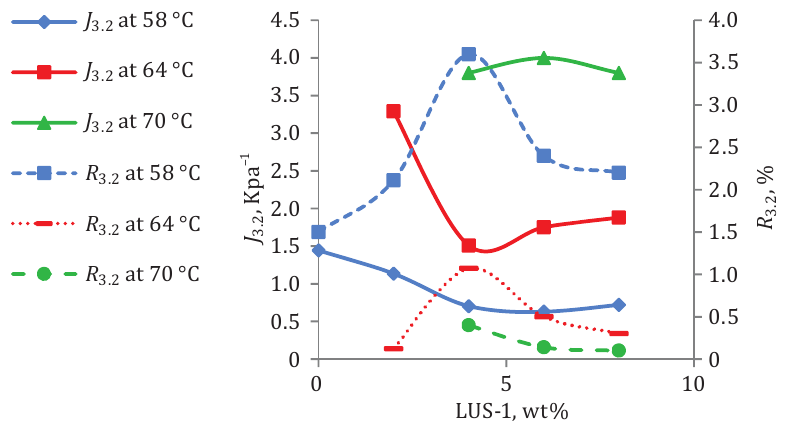
Figure 4. Effect of modifier content and temperature levels on J 0.1 and R 0.1